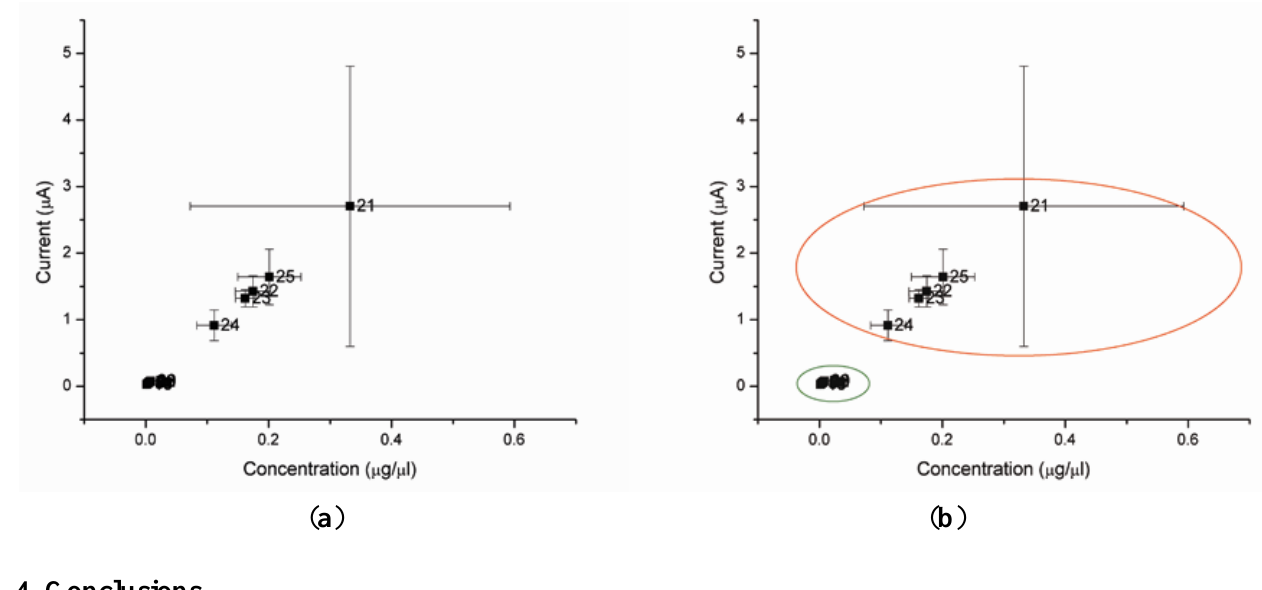
Figure 4. ( a , b ) Biosensor reading from the plasma of 24 test subjects. Samples 1–9 are from healthy men. Samples 11–20 are from men with HGPIN. Samples 21–25 are from men with prostate cancer (Gleason score 6–7). (Note: Sample 10 is not